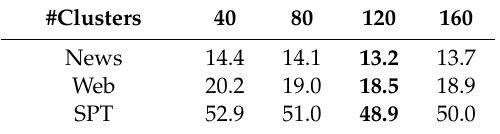
Table 4. Word error rate (%) of the Pho-LTV-Kmeans units according the number of clusters.